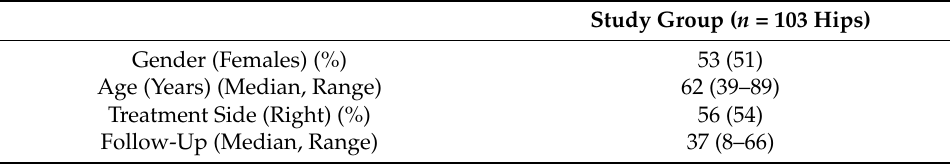
Table 1. Study Group